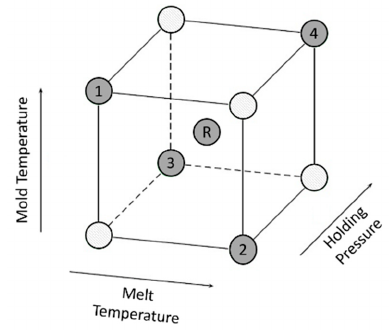
Figure 1. Applied settings of the experimental space for the fractional factorial design after [33].